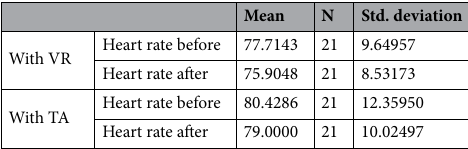
Table 2. Heart rate before and after the treatment for each type of procedure.